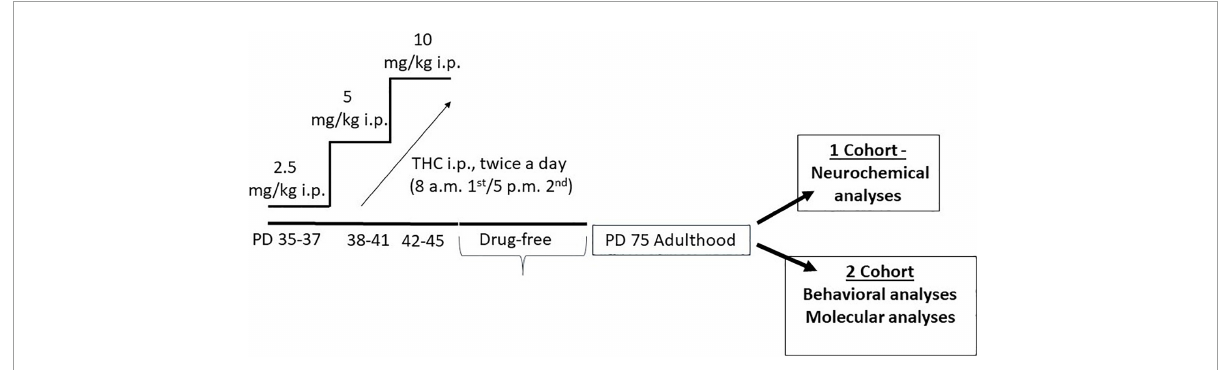
FIGURE2 Schematic representation of adolescent tetrahydrocannabinol treatment protocol and experiment